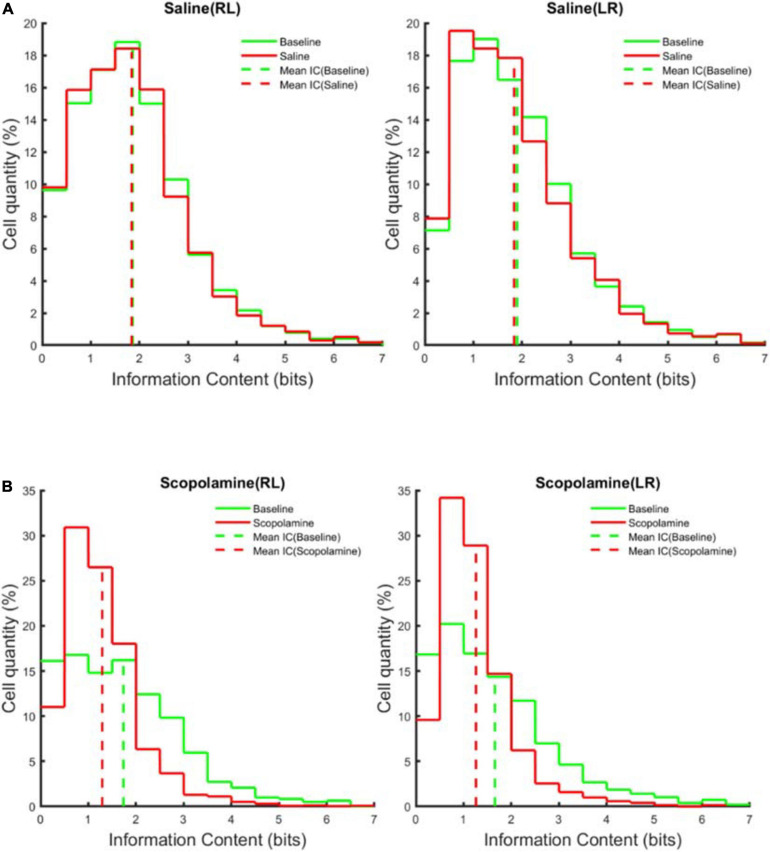
The average information content distribution of the cells measured across five animals before (green solid line) and after (red solid line) (A) saline or (B) scopolamine (1 mg/kg) injection in right-to-left (RL) and left-to-right (LR) running directions. The dashed vertical line represents the mean information content.